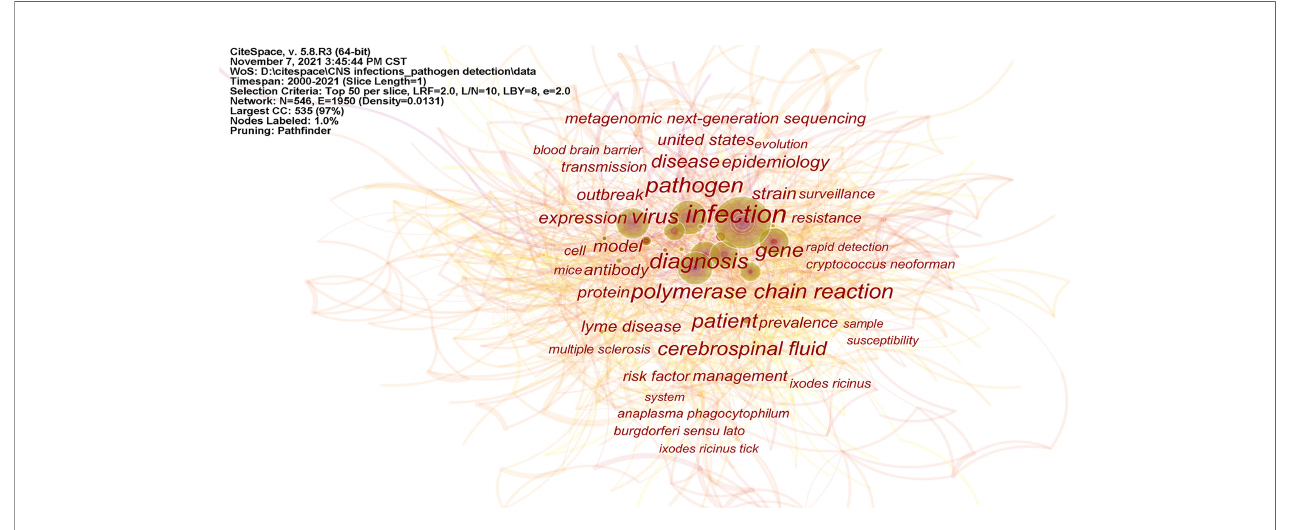
FIGURE 5 | The network organized by co-occurrence keywords.